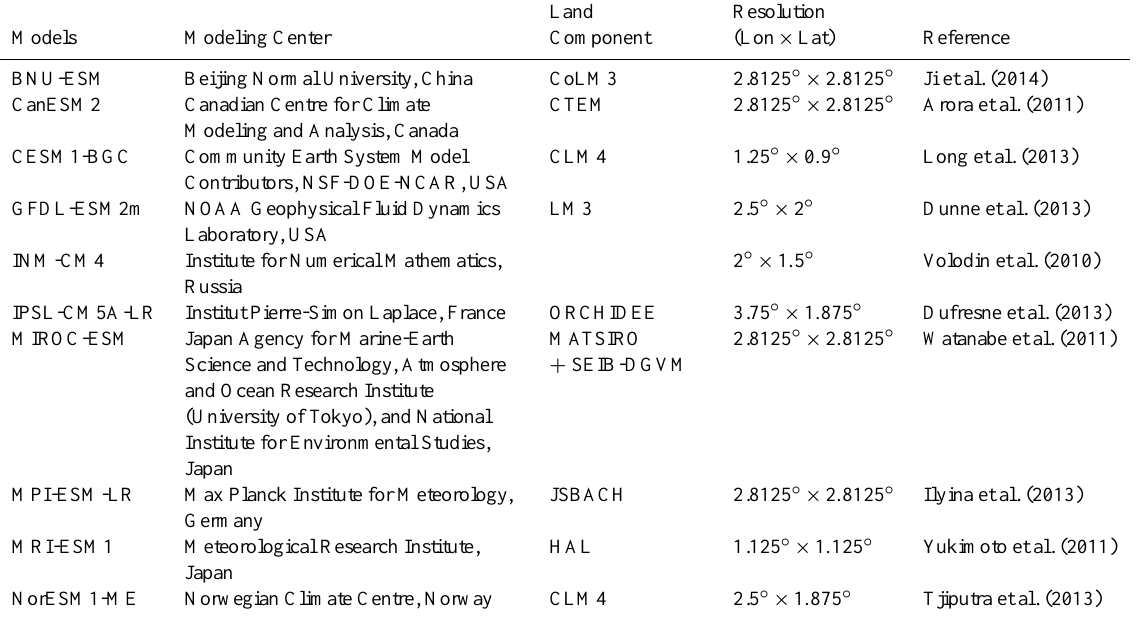
Table 1. List of Models used and their